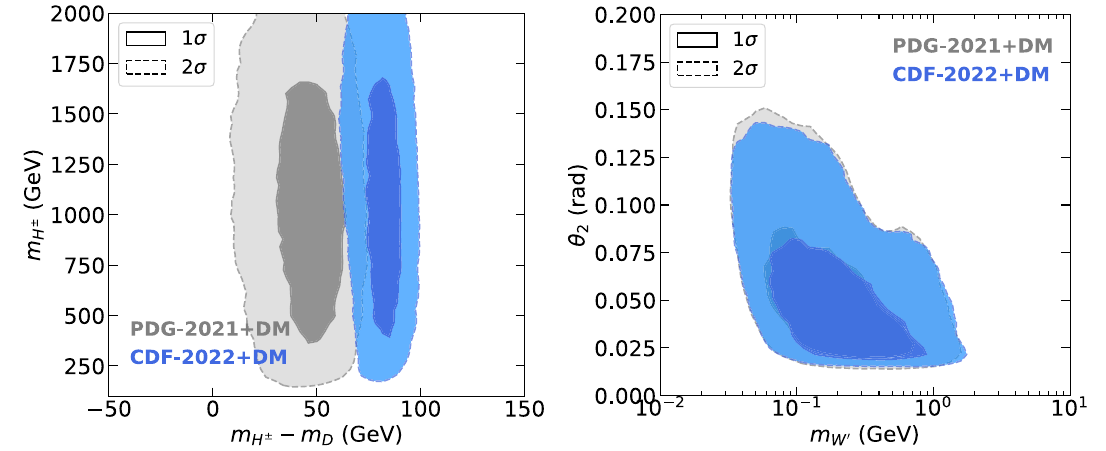
Fig. 12 Same as Fig. 11 for the light DM mass scenario but with the DM constraints included. The dark (light) blue region represents the 1 σ (2 σ ) favored by the CDF-2022+DM , while the dark (light) gray region indicates the 1 σ (2 σ ) favored by the PDG-2021+DM